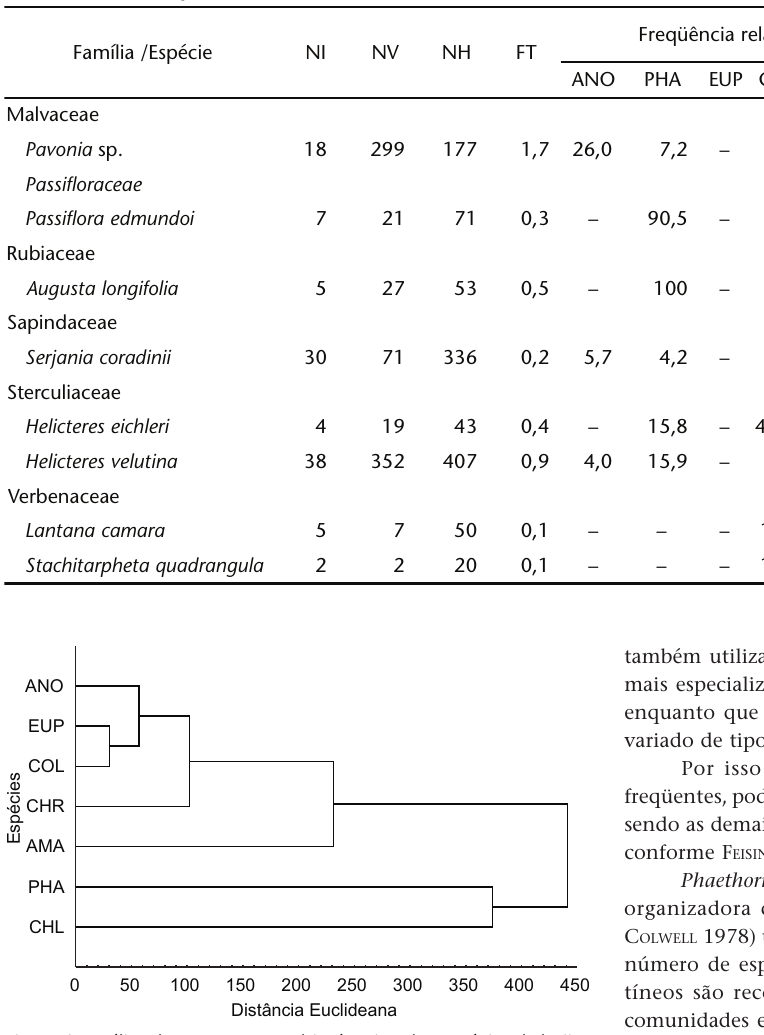
Figura 1. Análise de agrupamento hierárquico das espécies de